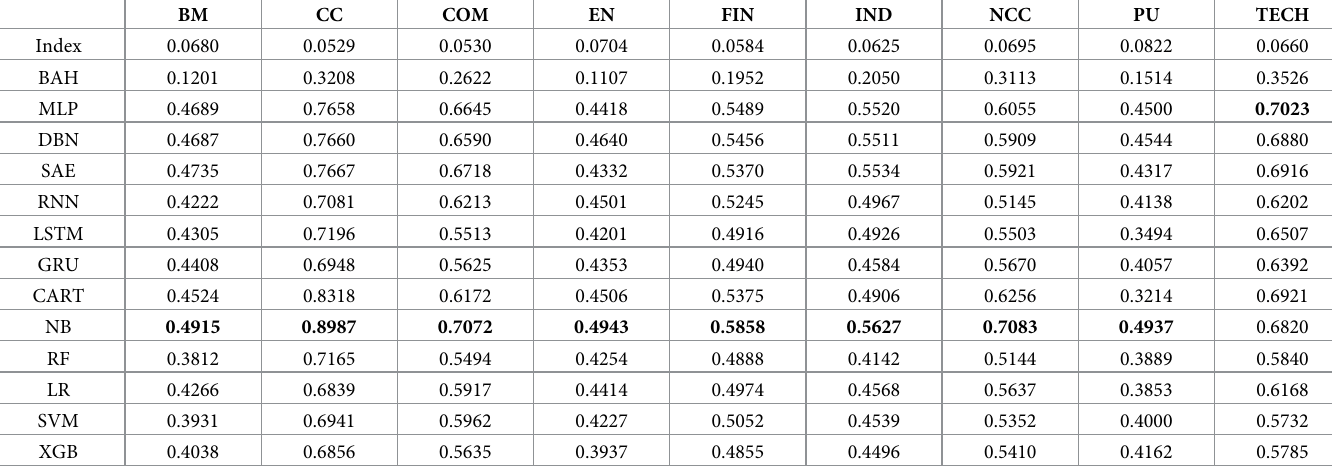
Table 9. Comparison of the ARR of various trading strategies in the different industries of CSICS. Best performance is in boldface. BM